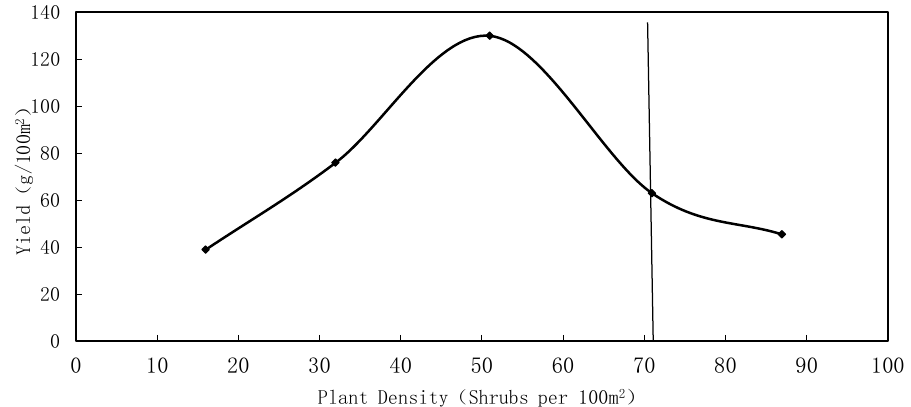
Figure 6. The relationship between plant density, carrying capacity, and caragana seed yield in the semiarid hilly Loess region.